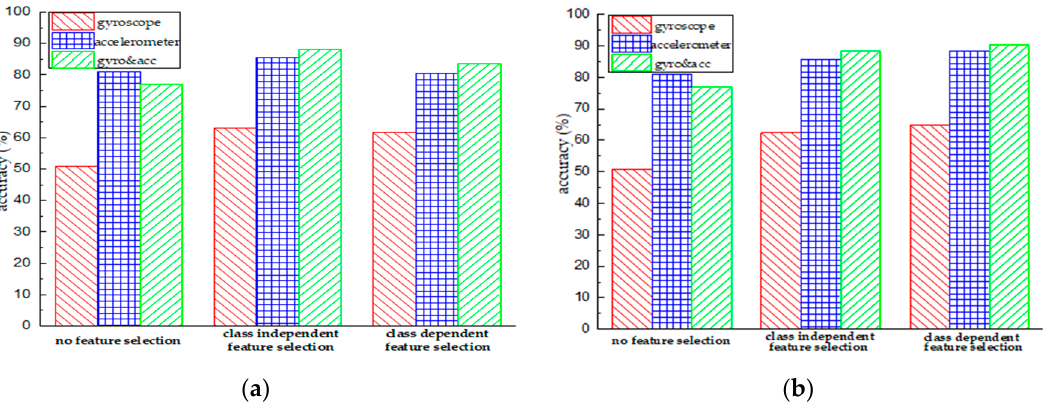
Figure 7. Performance comparison of using different sensing units in the case of no feature selection, class independent feature selection, and class dependent feature selection. ( a ) Performance obtained using the non-hierarchical model; ( b ) Performance obtained using the hierarchical model.